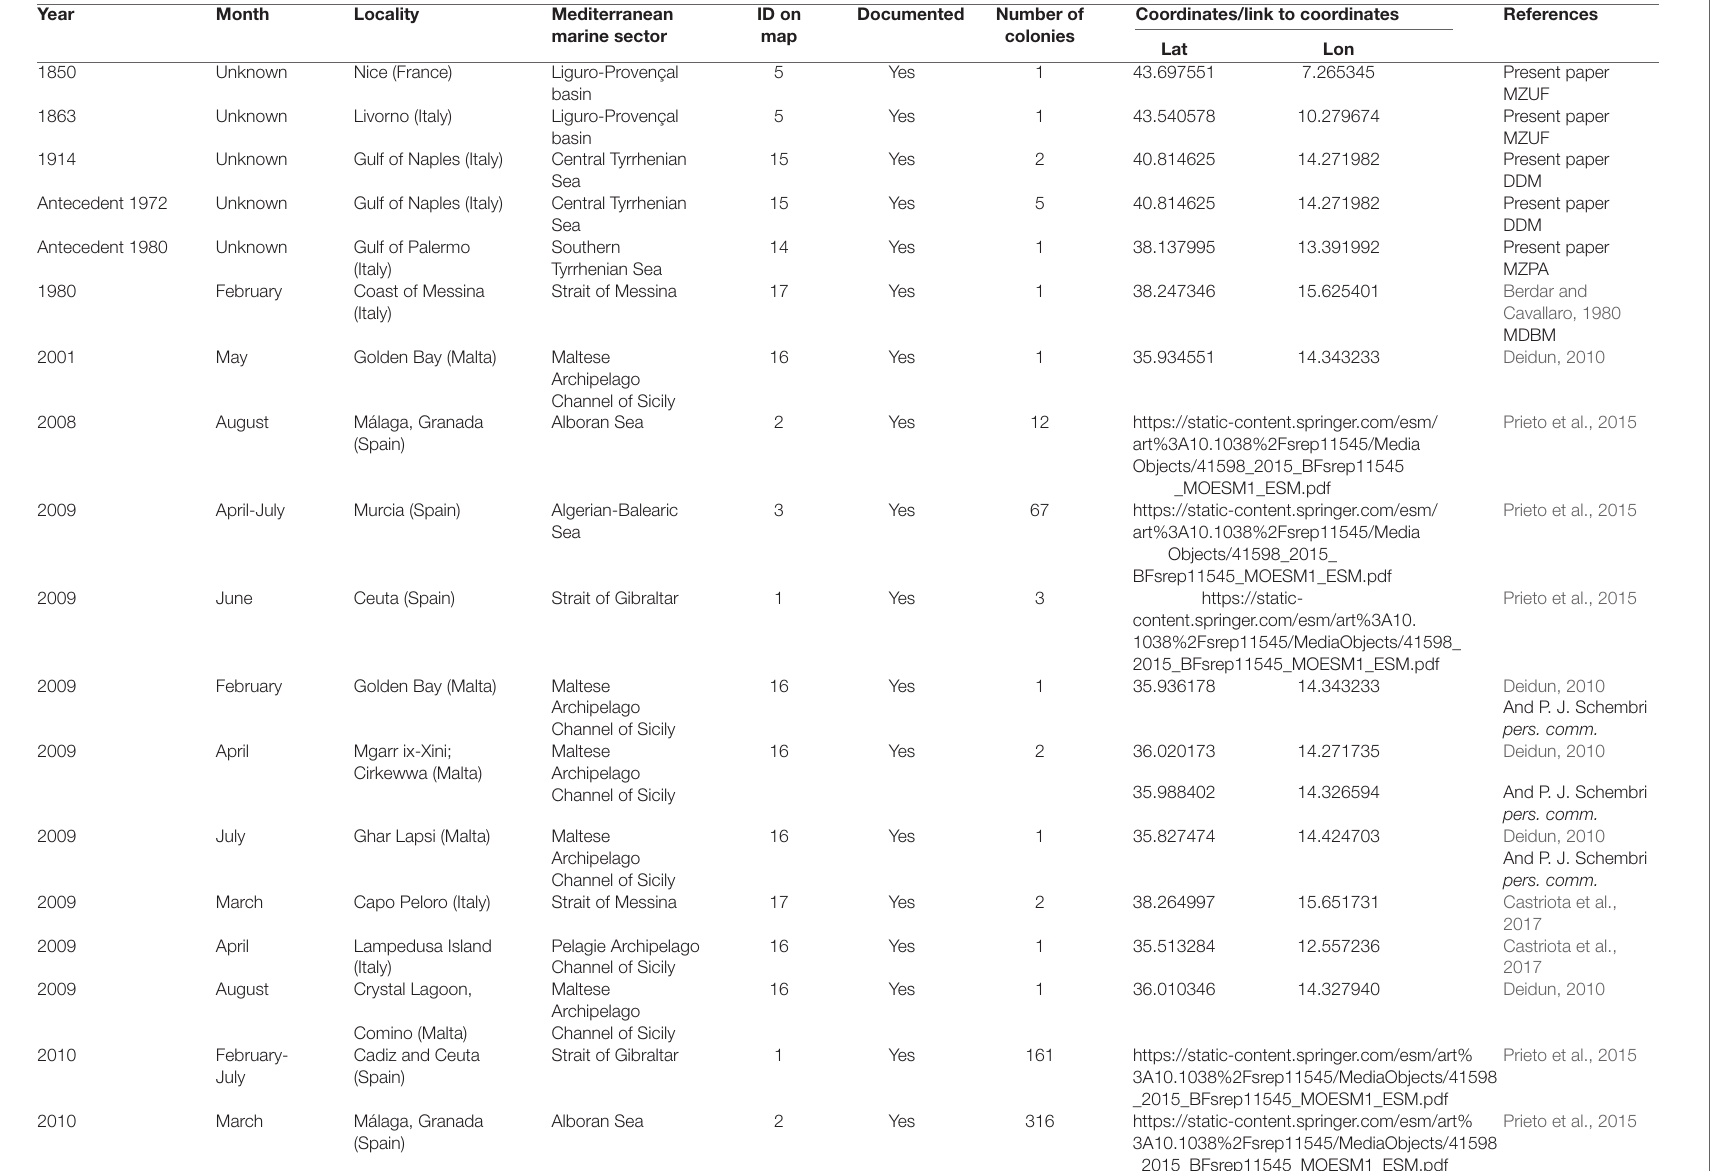
TABLE 1 | Records of Physalia physalis in the Mediterranean Sea,pointed out in the map of Figure 1 .